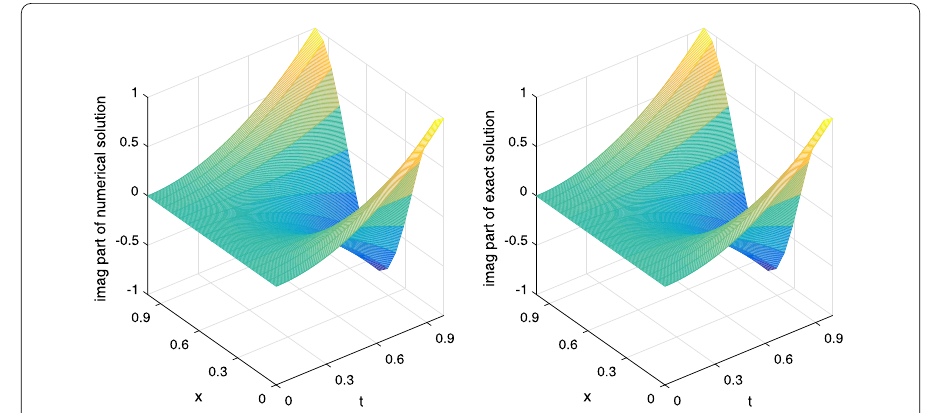
Figure 2 (Example 6.1) Imaginary part of numerical solution and exact solution